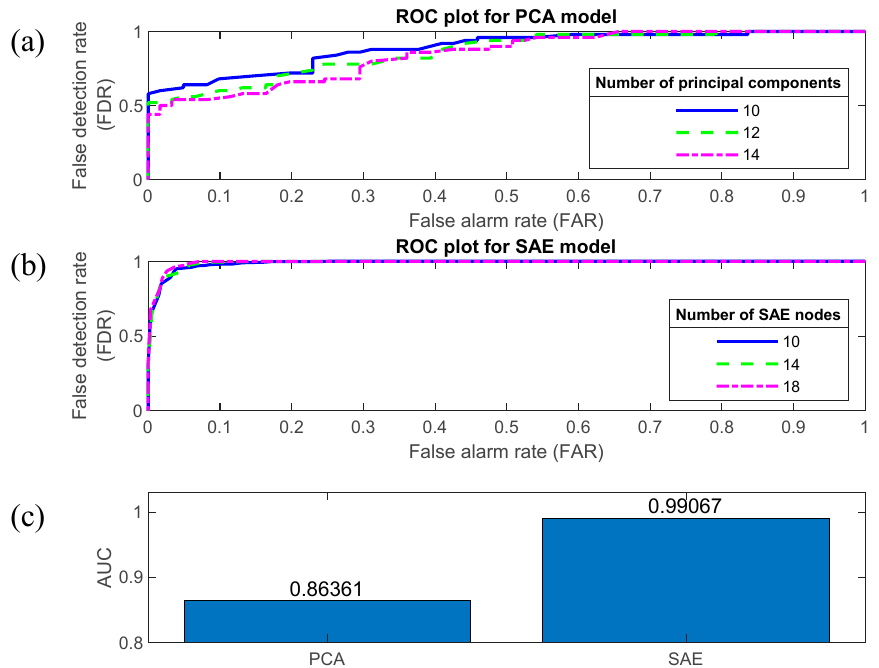
Figure 15. ROC curves and average AUC values for detection of the misalignment: ( a ) ROC curves for the PCA model with a different number of principal components; ( b ) ROC curves for the SAE model with a different number nodes in the hidden layer; ( c ) average AUC values of PCA and SAE models.